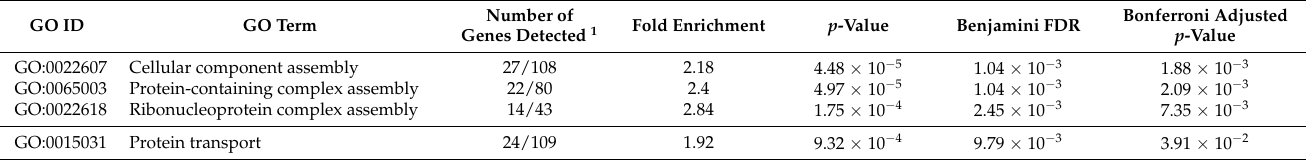
Table 2. Analysis of biological processes enrichment in the PbPP1c interactome in gametocytes limited to GO SLIM